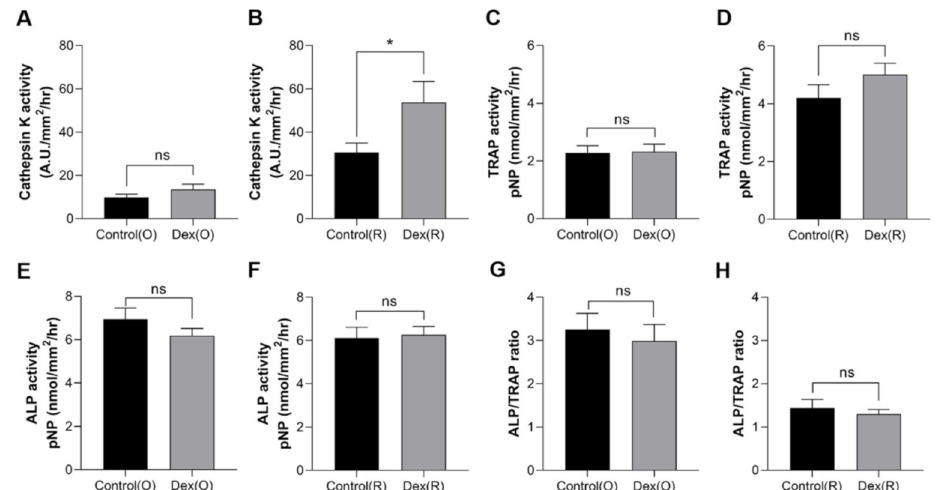
Figure 6. Enzymatic activities of scale lysates from the control (black bar) and dexamethasone-treated groups (gray bar) on day 5 of the experiment. Cathepsin K activity of ( A ) ontogenetic scales and ( B ) regenerated scales, TRAP activity of ( C ) ontogenetic scales and ( D ) regenerated scales, ALP activity of ( E ) ontogenetic scales and ( F ) regenerated scales, and ALP/TRAP ratio of ( G ) ontogenetic scales and ( H ) regenerated scales. Comparisons between groups were assessed with Student’s t -test. Data are shown as the mean ± SEM (* p ≤ 0.05; ns: not significant). Error bars indicate the standard error of the mean.